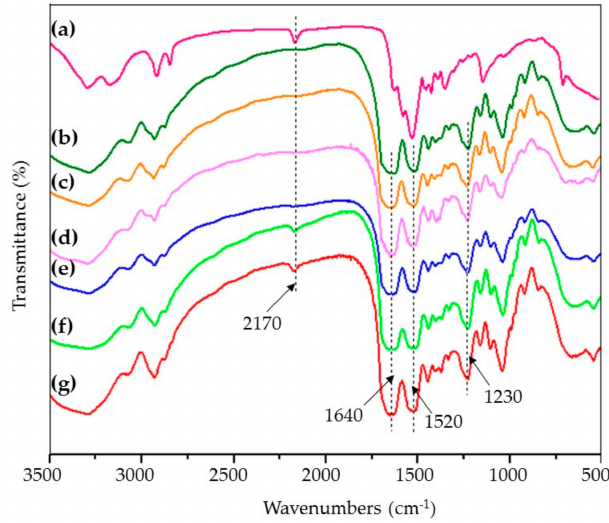
Figure 4. Fourier transform infrared (FTIR) spectra of porous PHMB / SF sponges. PHMB / SF